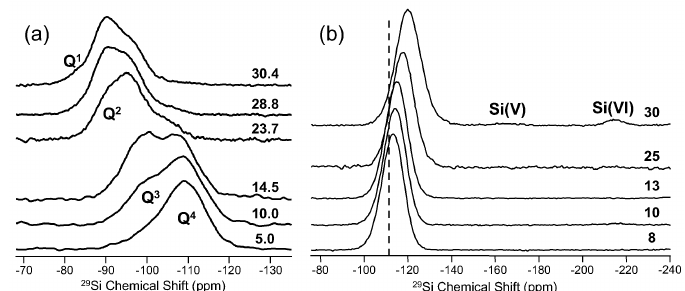
Figure 4. 29 Si MAS NMR spectra for ( a ) a series of binary cesium silicate glasses [25], with Cs 2 O content in mol % to the right of each trace; and ( b ) a series of binary P 2 O 5 -SiO 2 glasses with mol % P 2 O 5 shown to the right, adapted from [29] with permission from Cambridge University Press. Q n species are labeled according to their chemical shifts (peak positions) in ( a ), and in addition to the main Q 4 peak in ( b ), weak NMR signals from five- and six-fold coordinated silicon atoms are marked. The vertical dashed line in ( b ) marks the chemical shift of Q 4 tetrahedra in pure